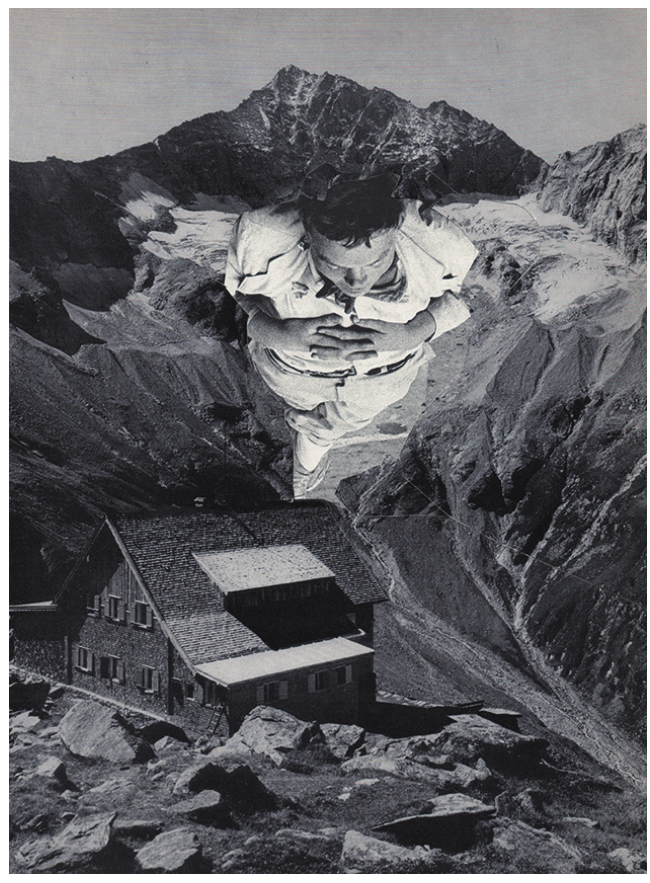
Fig. 1 Sabine Hertig, Untitled